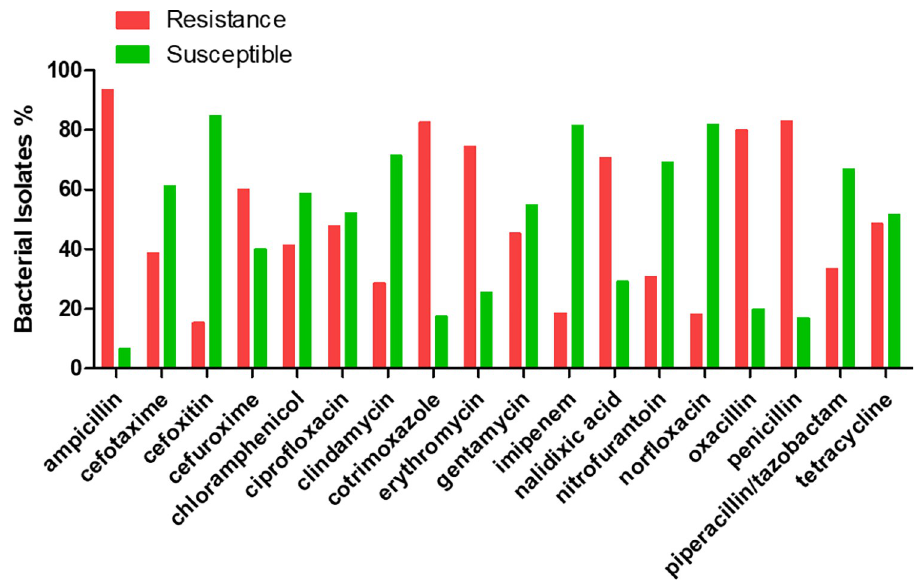
Fig 5. The susceptibility patterns of isolates from in-patient departments. Data indicates strains resistance to ampicillin, cotrimoxazole, nalidixic acid, erythromycin, oxacillin, and penicillin. While imipenem, norfloxacin, clindamycin and nitrofurantoin retained their effectiveness.